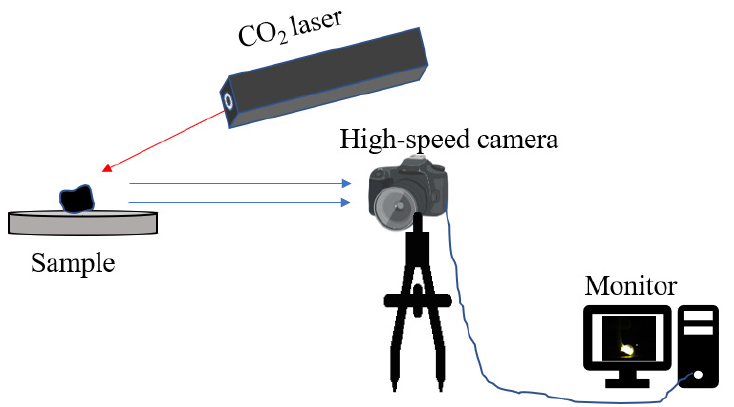
Figure 7. The CO 2 laser ignition schematic .